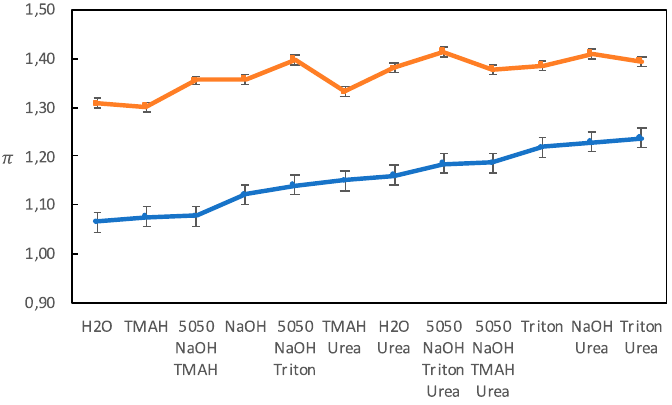
Figure 5. The π -values obtained with two di ff erent probes, 4-nitroanisole (blue circles) and Figure 5. The π ‐ values obtained with two different probes, 4 ‐ nitroanisole (blue circles) and N,N ‐ N,N -diethyl-4-nitroaniline (orange squares) for the di ff erent solvents. diethyl ‐ 4 ‐ nitroaniline (orange squares) for the different solvents.